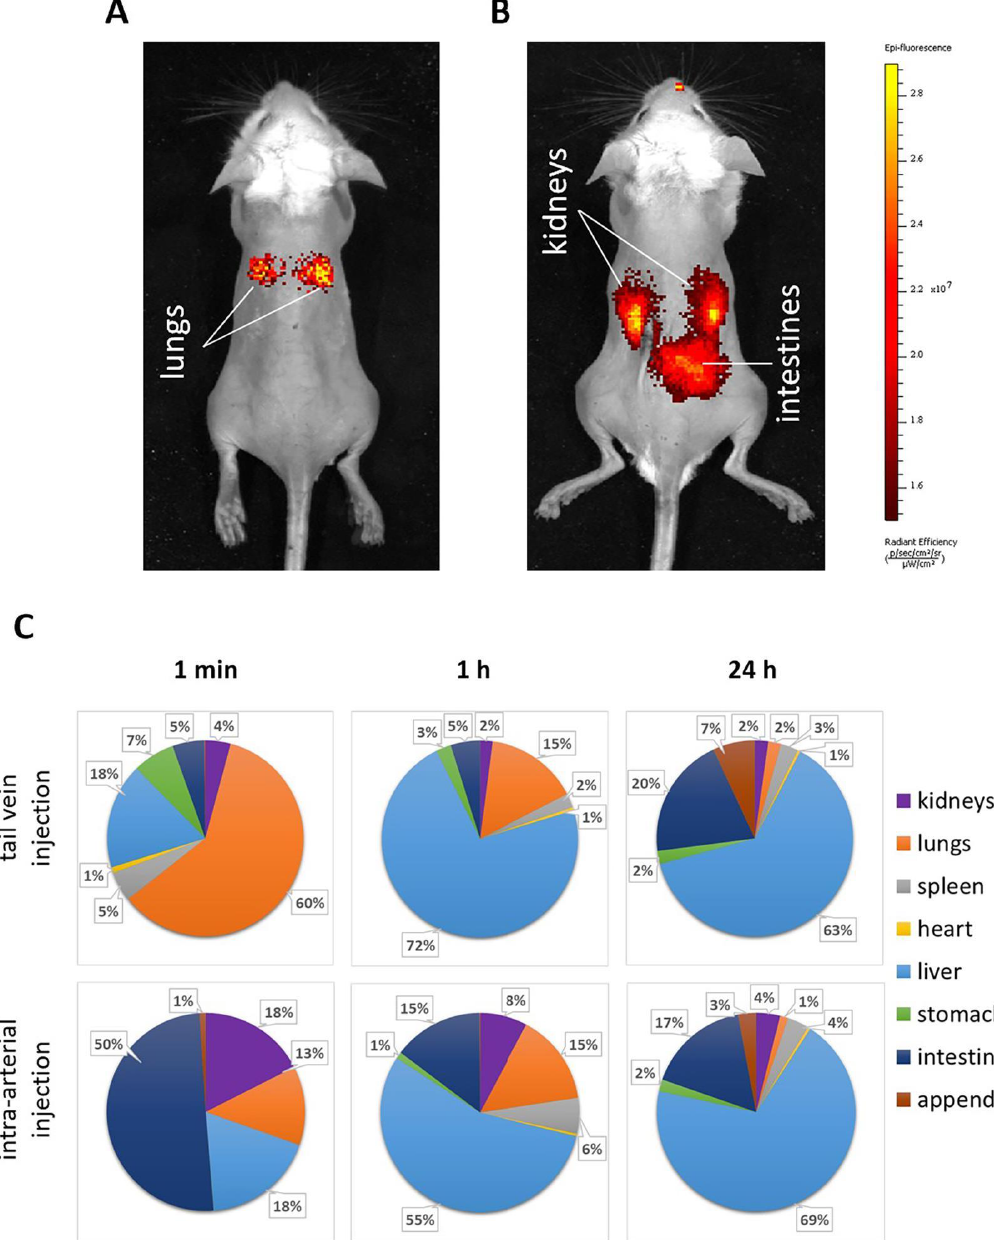
Figure 3. Biodistribution of the fluorescent signal in vivo ( A ) at 1 min, tail vein injection; ( B ) at 1 min, renal arteries injection) and ex vivo ( C ) in dynamics) after injection of microcapsules with etanercept-Cy7 via the tail vein or renal arteries through the abdominal aorta (intra-arterial injection). Negligible (<1%) ex vivo fluorescent signal ( C ) was not labeled.